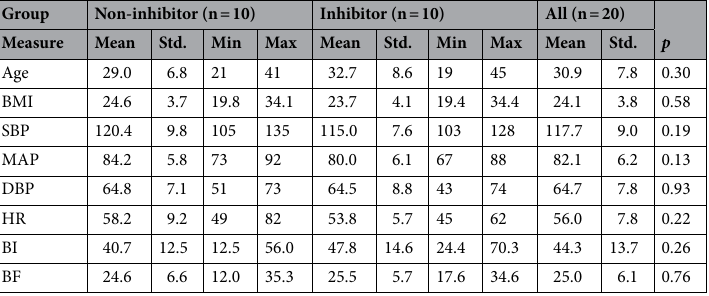
Table 1. Subject characteristics. Participants grouped by MSNA inhibition. Std . standard deviation of the mean, Min minimum value, Max maximum value, p p -value from independent samples T-test for difference between Non-inhibitor and Inhibitor groups, BMI body mass index, SBP resting systolic blood pressure, MAP resting mean arterial pressure, DBP resting diastolic blood pressure, HR resting heart rate, BI resting MSNA burst incidence (per 100 heart beats), BF resting MSNA burst frequency (per